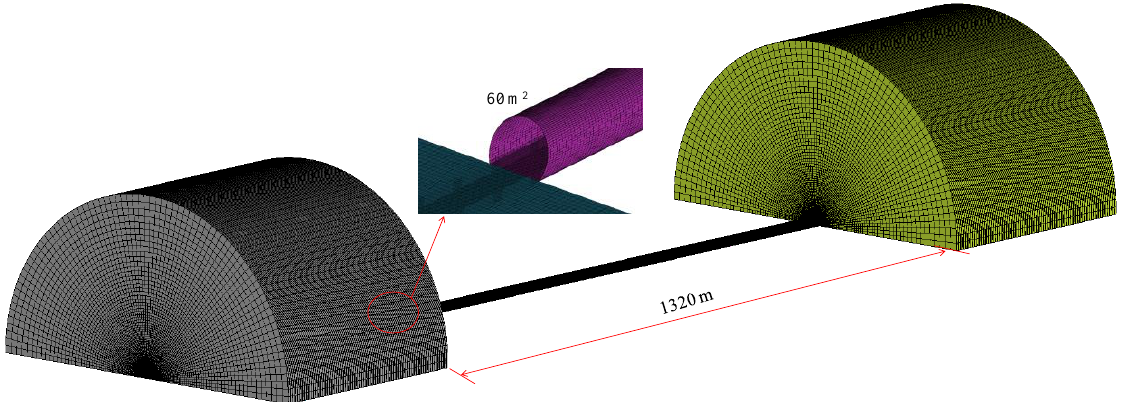
Figure 12. The numerical model corresponding to the field test.